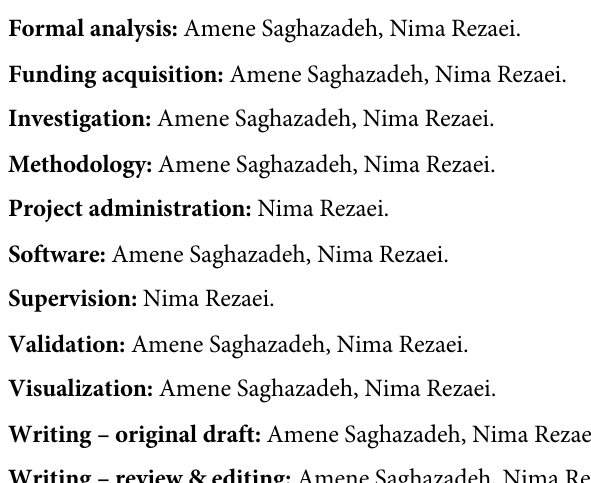
S22 Fig. Subgroup meta-analysis of pleural VEGF levels in patients with TPE vs. patients with transudate, CHF/CRF, or cirrhotic effusion by geographic location. S1 Table. Characteristics of studies included in the meta-analysis of VEGF. S2 Table. The quality of studies included in the meta-analysis of VEGF ranked using the Newcastle-Ottawa Scale. S3 Table. Subgroup meta-analysis results summary. S4 Table. Meta-regression results